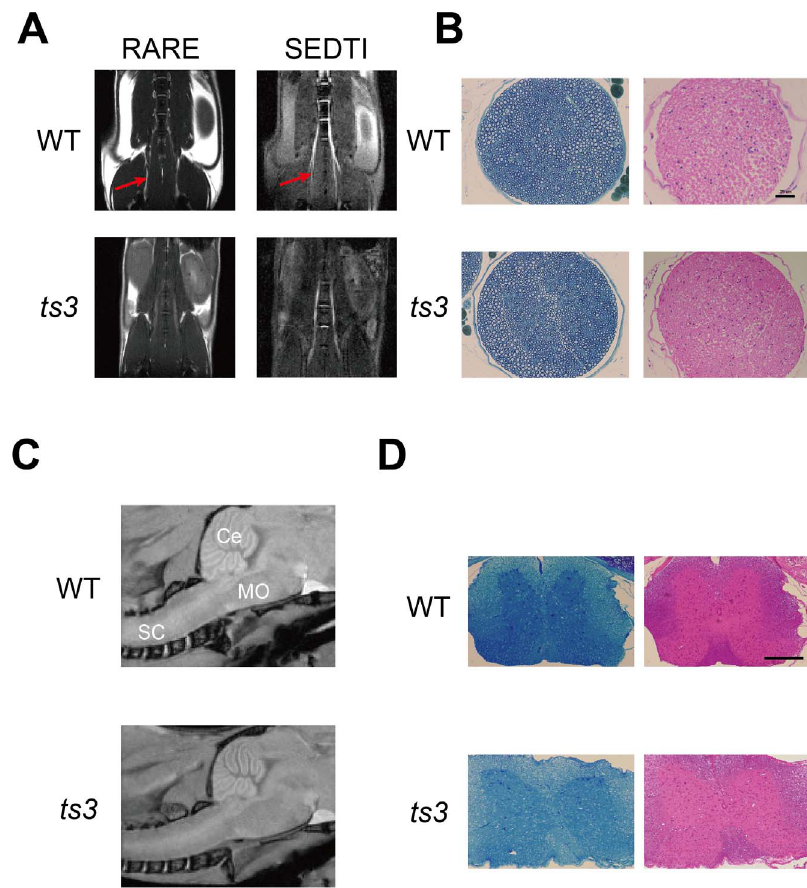
Figure 3. Normal morphology for spinal cord and sciatic nerves. A) No significant abnormality in the sciatic nerve (arrow) was detected in ts3 mutants by micro-MRI. B) Toluidine blue (left) and H&E staining (right) shows normal morphology of sciatic nerves in both genotypes. Scale bar: 25 m m. C) Micro-MRI sagittal images of brain stem and spinal cord in ts3 and WT mice. No abnormalities were detectable in ts3 . Ce: cerebellum, MO: medulla oblongata, SC: spinal cord. D) Toluidine blue and H&E-stained spinal cord of ts3 and WT mice. Spinal cord morphology was normal in both genotypes, and no significant difference was observed. Scale bar indicates 100 m m.